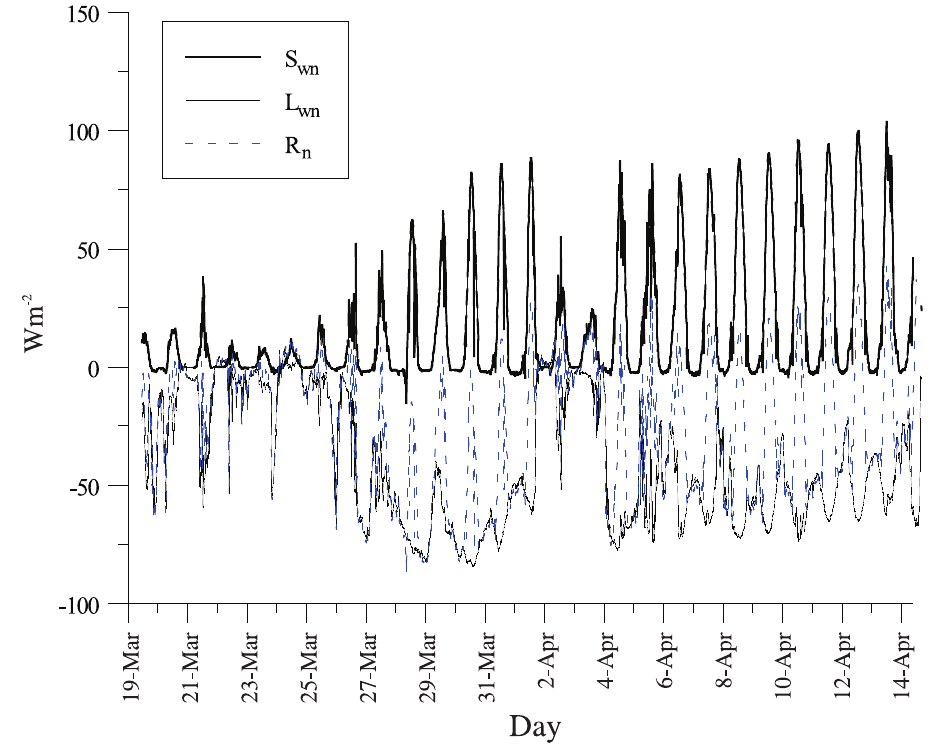
Fig. 9. Behaviour of the net radiation, longwave net radiation and shortwave net radiation for the whole measurement